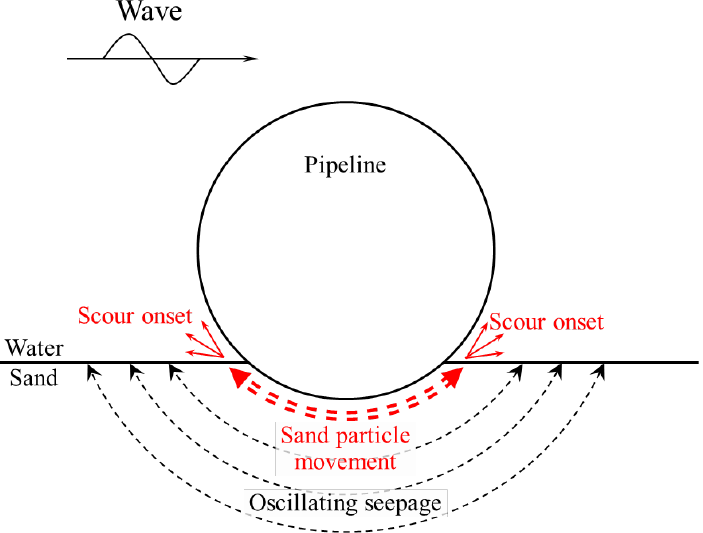
Figure 1. Sketch for the scour onset under a pipeline in waves.